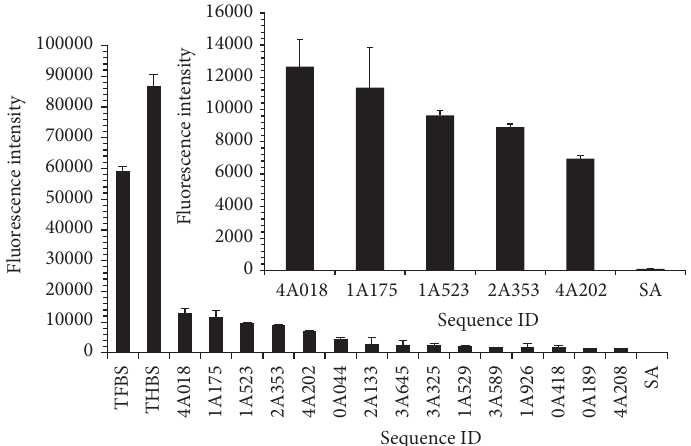
Figure 1: Microarray performance of the top 15 ranked potential thrombin binders of PT2 compared to controls. Inset: close-up view of the intensitiesofthetop5rankedsequencescomparedtothenegativecontrol.Errorbarsrepresentstandarddeviationofreplicatesoffluorescence values obtained from a 2 h incubation of 100 nM Cy3-thrombin with the microarray at 20 ∘